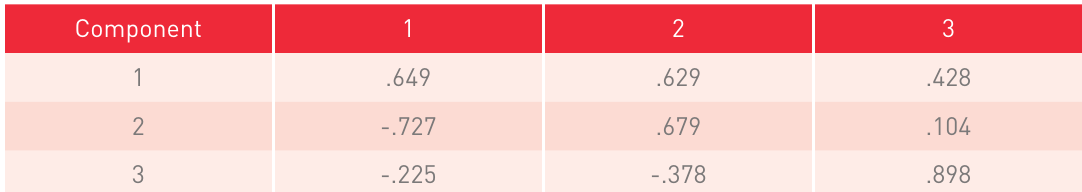
Component Transformation Matrix